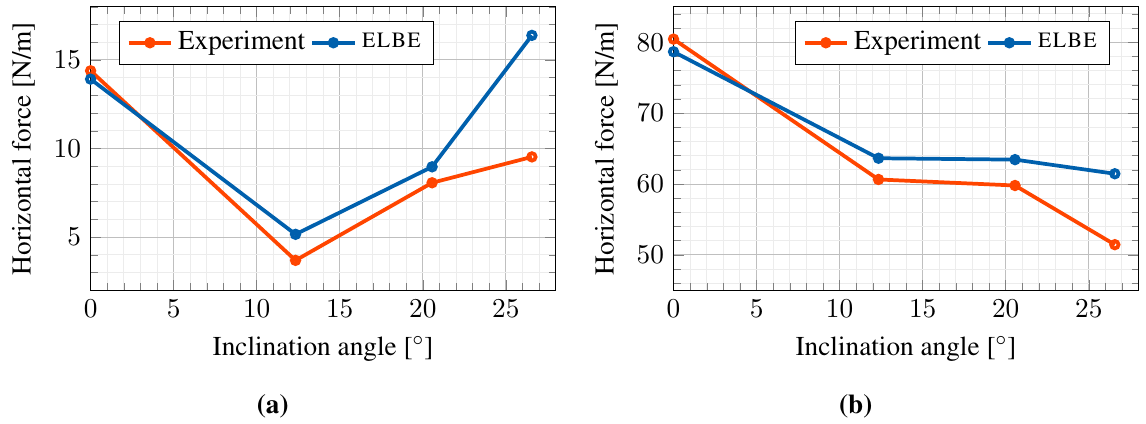
Figure 24. Comparison of horizontal forces in experimental and numerical wave tanks for two different scenarios, as a function of inclination angle. ( a ) Current condition C3; ( b ) wave condition H3.